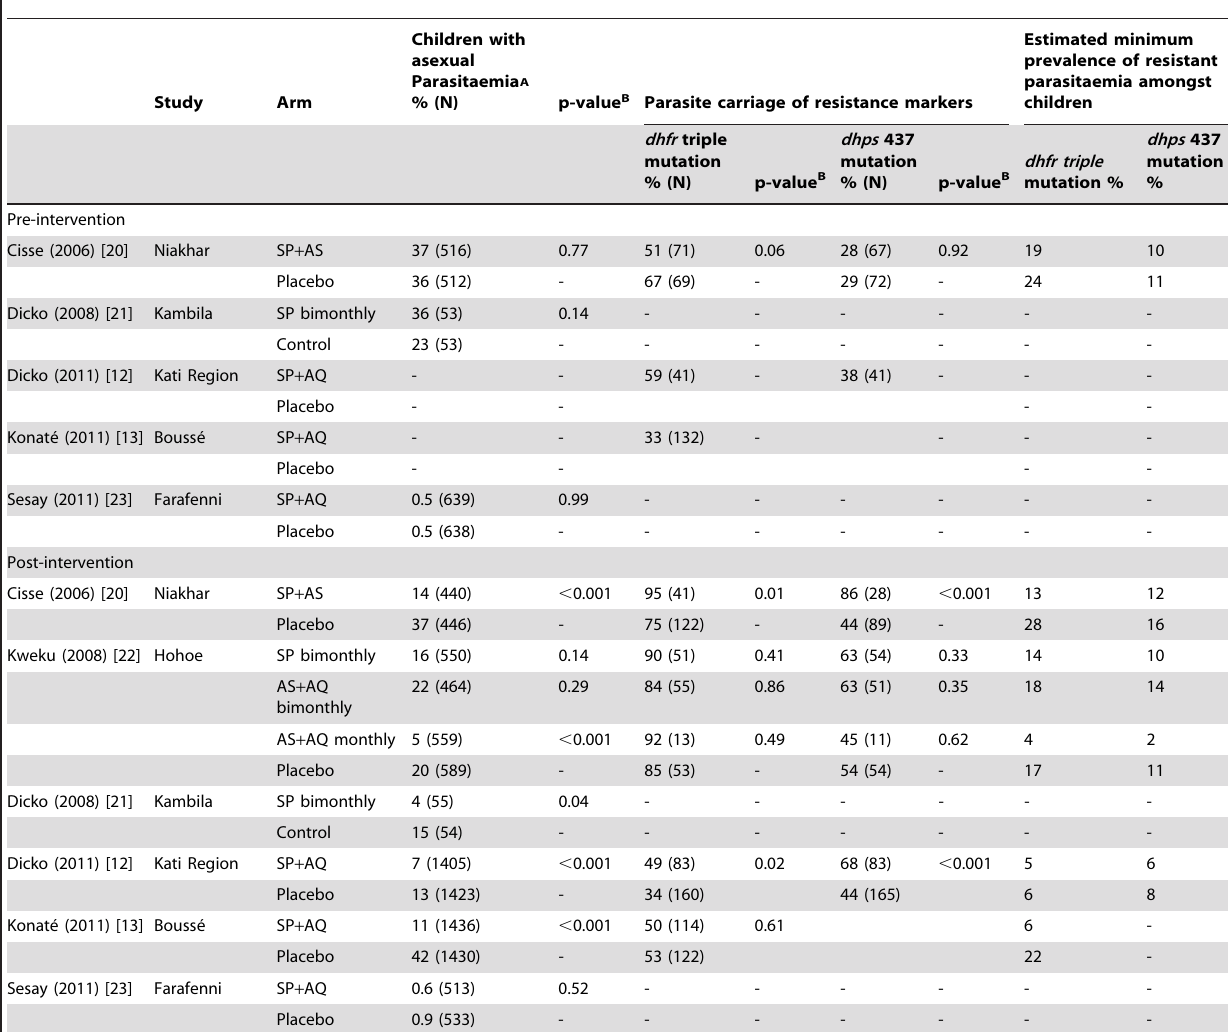
Table 6. Effect of IPTc on prevalence of parasitaemia, dhps and dhfr resistance markers measured at cross sectional surveys during the intervention